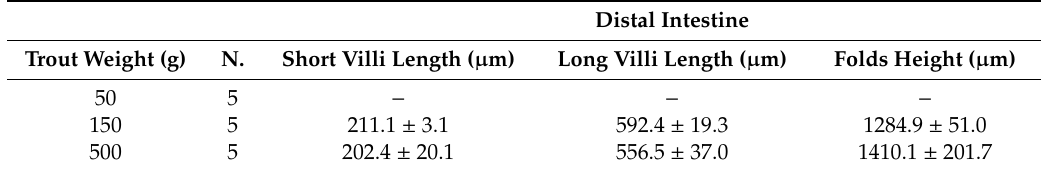
Table 4. Evaluation of distal intestine histometry in rainbow trout along the first year of development.